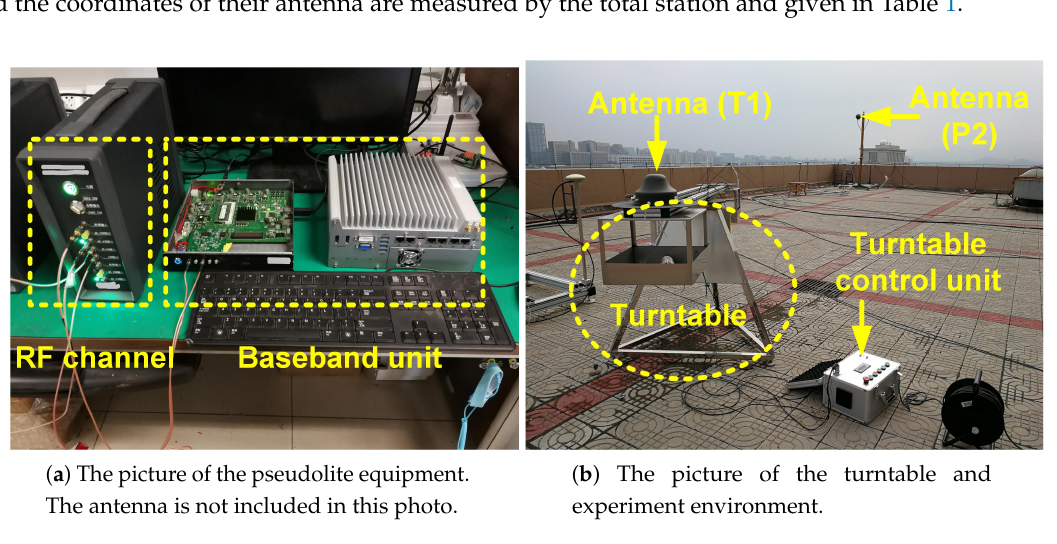
Figure 5. The picture of the prototype pseudolite system and the experiment